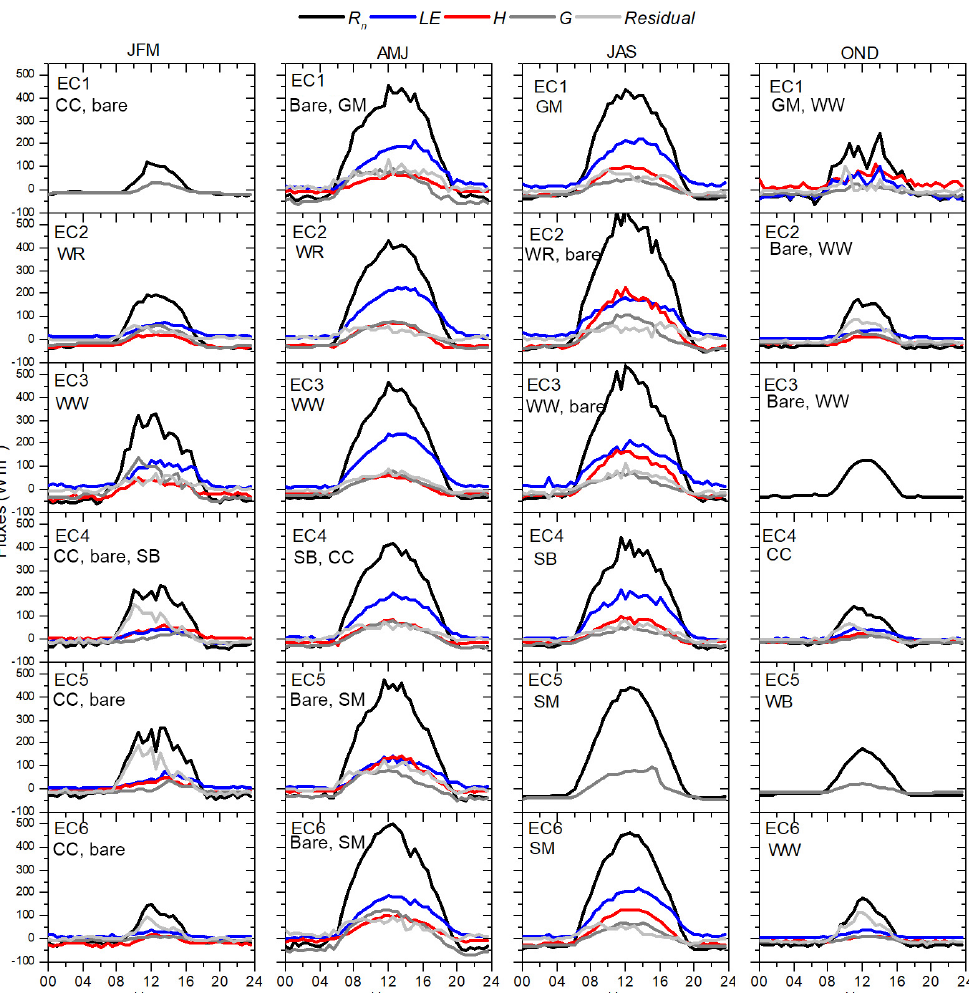
Figure 4. Diurnal courses of energy balance components averaged over 3-month periods in Kraichgau (EC1, EC2, and EC3) and Swabian Jura (EC4, EC5, and EC6) in 2016. Insets denote the different crops grown in 2016; see main text for explanation. Because of energy shortage during winter at the EC1, EC3, EC4, and EC5 sites, the fluxes shown in the JFM and OND graphs were measured only in March and from 1 October to mid-November,